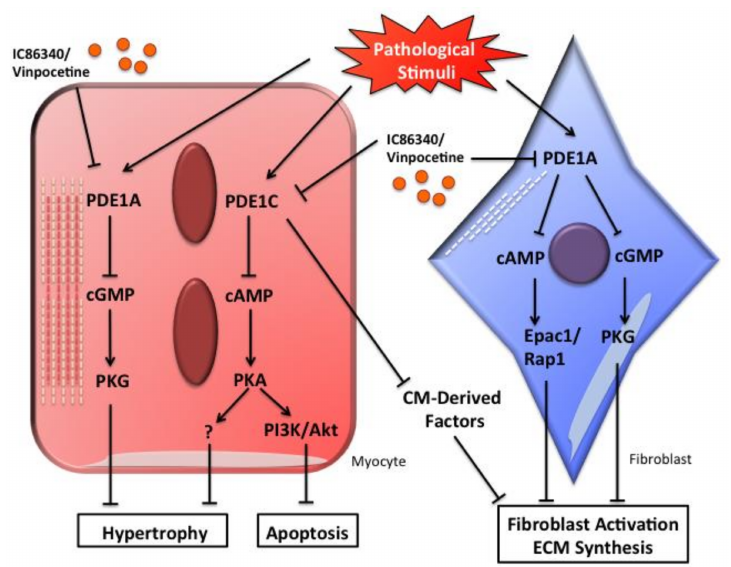
Figure 1. Schematic diagram showing the potential role of PDE1A and PDE1C in regulating pathological cardiac remodeling including cardiac hypertrophy and fibrosis. In cardiac myocytes, PDE1A-dependent regulation of cGMP/PKG signaling alleviates myocyte hypertrophy, PDE1C-dependent regulation of cAMP/PKA signaling suppresses both myocyte hypertrophy and apoptosis. In cardiac fibroblasts, PDE1A-dependent dual regulation of cAMP-Epac1-Rap1 and cGMP-PKG signaling decreases fibroblast activation and ECM synthesis, whereas PDE1C may regulate cardiac fibrosis through paracrine signaling between cardiac myocytes and